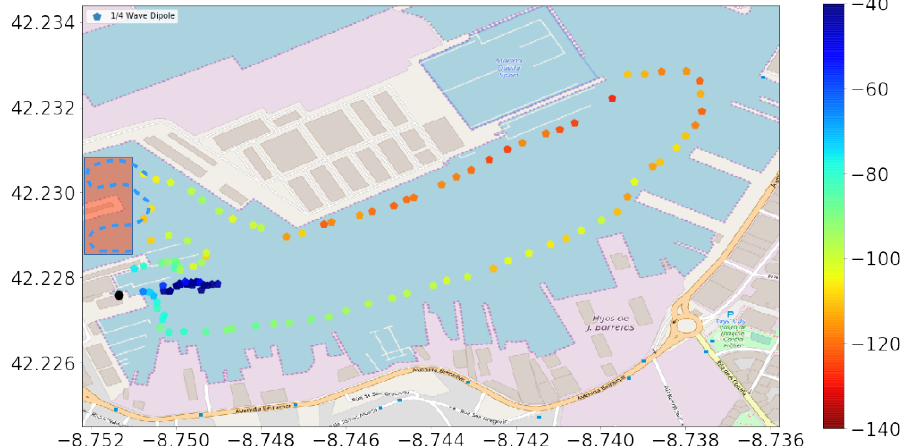
Figure 10. RSSI (Received Signal Strength Indicator) reception levels (dBm) in the port area with LoRa’s SF7.